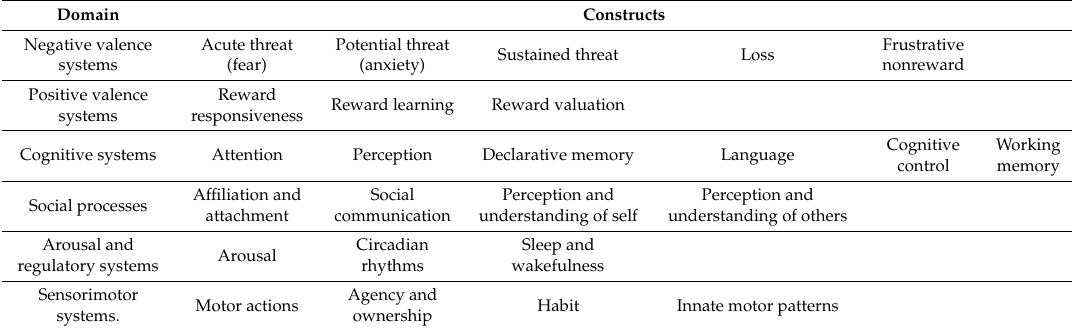
Table 2. Current list of NIMH RDoC domains and